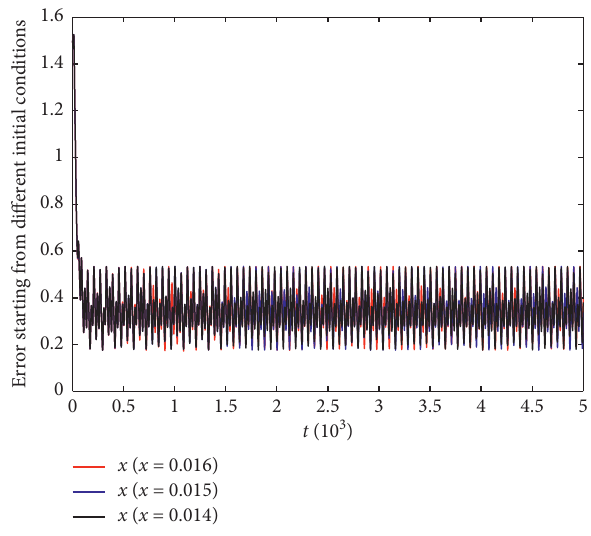
Figure 5: System (1) sensitivity analysis.